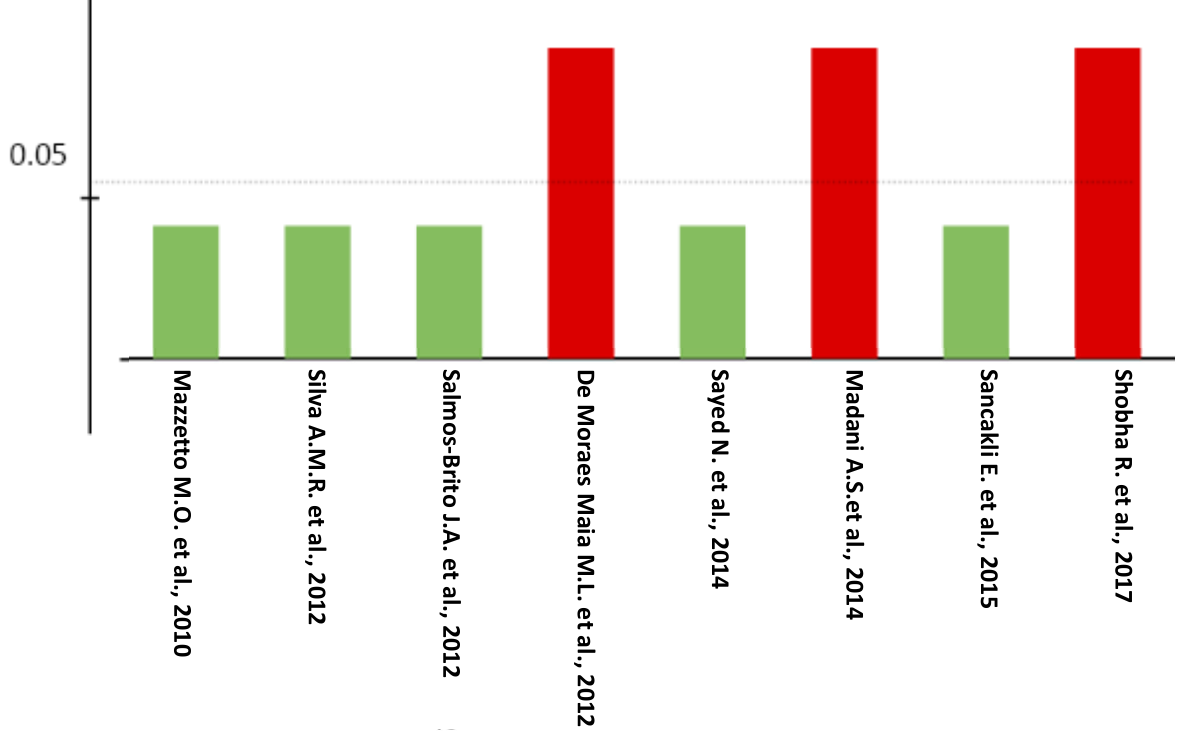
Figure 5. Statistical analysis of the final included studies. Red, non-significant; Green, significant.